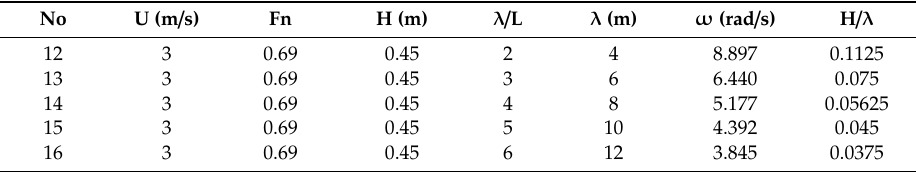
Table 13. The parameters of regular wave, in which U = 3 m / s.